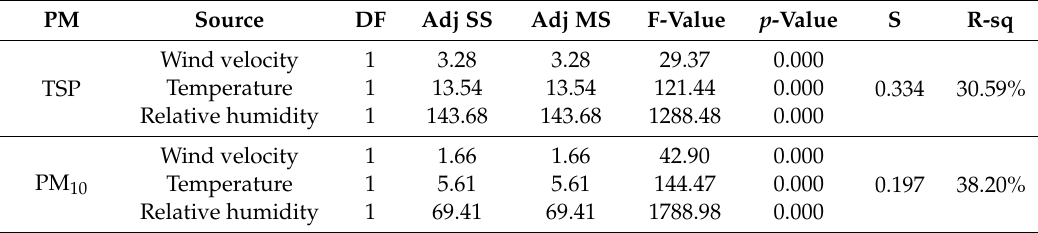
Table 2. Linear regression analysis of meteorological factors and atmospheric suspended particulate matter